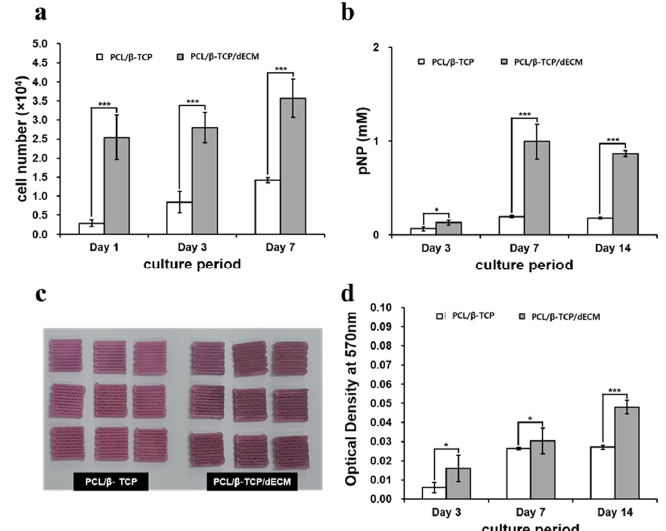
Figure 5. Proliferation and osteogenic differentiation assays: ( a ) The cell counting kit-8 (CCK-8) assay